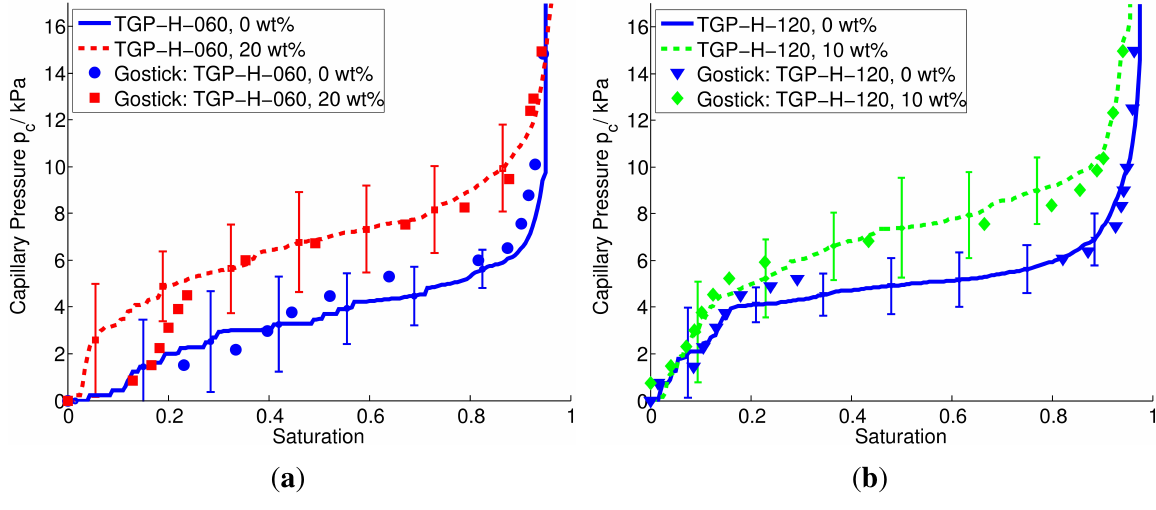
Figure 7. Calculated capillary pressure-saturation curves for ( a ) Toray TGP-H-060 and ( b ) Toray TGP-H-120 with different PTFE content. The mean values and standard deviations of twenty GDL realizations are compared to data derived by Gostick et al. [31] for the same type of